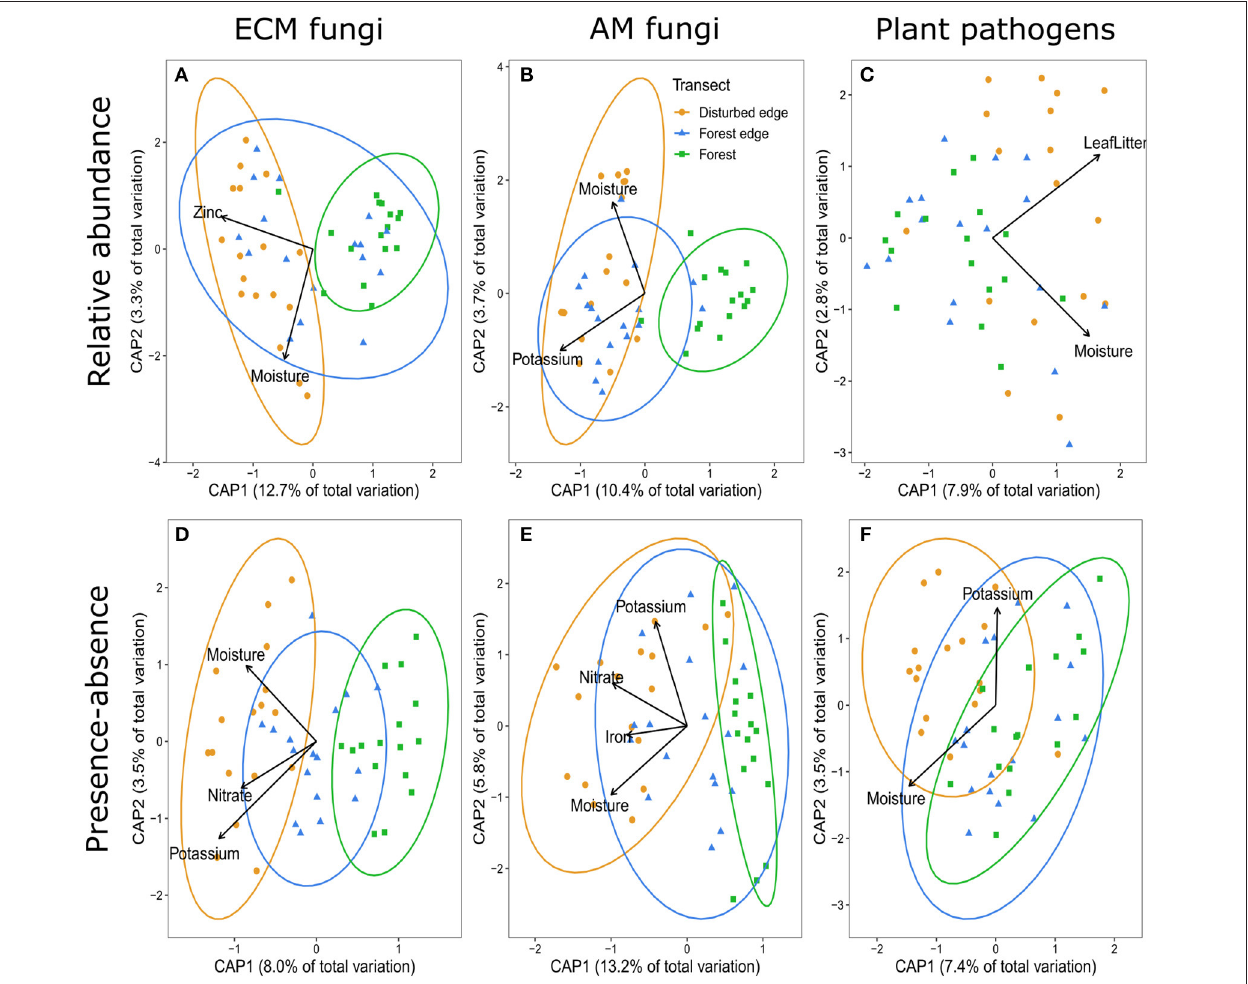
FIGURE 2 | Distance-based redundancy analysis (dpRDA) demonstrating the communities of (A,D) ectomycorrhizal (ECM) fungi, (B,E) arbuscular mycorrhizal (AM) fungi, and (C,F) putative fungal plant pathogens associated with Corymbia calophylla grown in soils collected across a disturbance gradient: filled orange circles represent the disturbed edge [i.e., remnant stand of C. calophylla bordering a road with anthropogenic disturbance (agricultural, horticultural, viticultural or grazing purposes)], filled blue triangles indicate forest edge, and filled green sqaures indicate 200m within a forest. Ellipses were included when disturbance significantly affected community composition. (A–C) represent the relative abundance (Bray-Curtis dissimilarity) of the communities and (D–F) represent presence-absence (Jaccard dissimilarity) of the